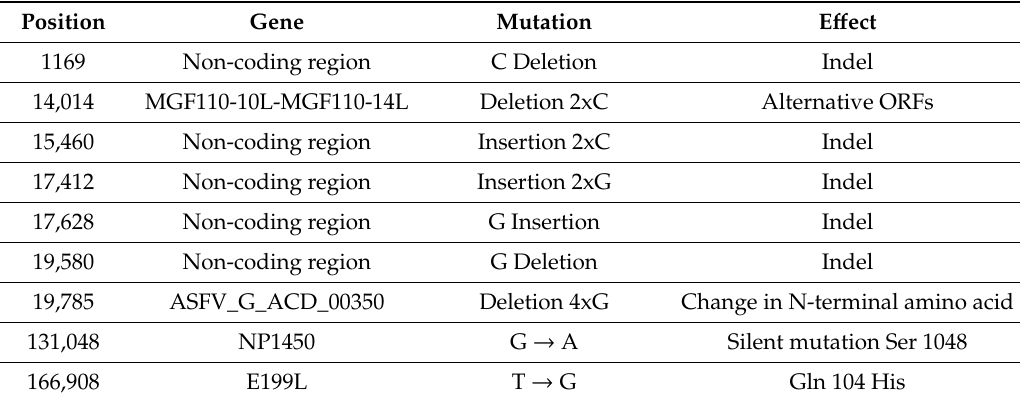
Table 7. Mutations observed on the alignment of ASFV Arm / 07 / CBM / c2 with the reference genome ASFV Georgia 2007 / 1 and their e ff ect on diverse coding